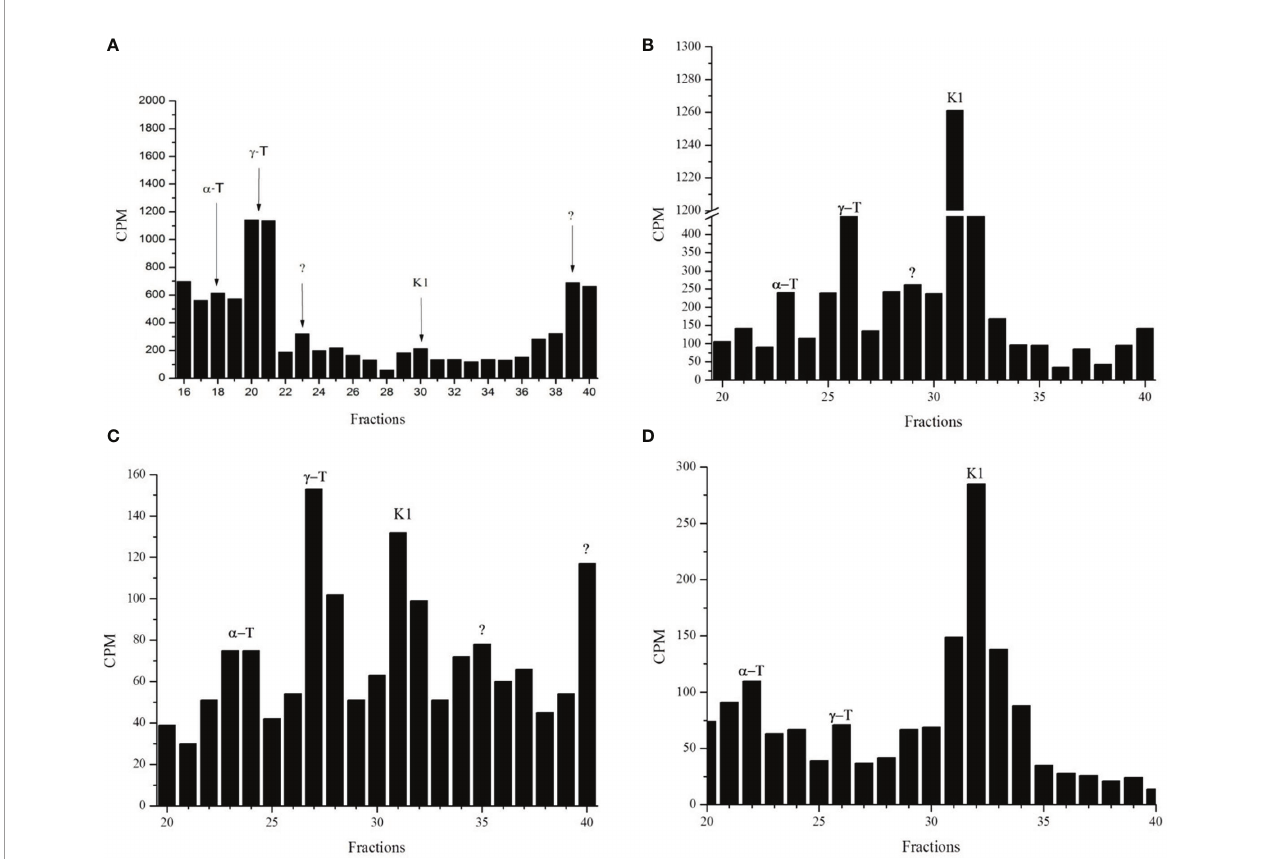
FIGURE 1 | Radioactive incorporation pro fi le for phytylated quinones in P. falciparum in schizont stage. Infected erythrocytes with schizont stages metabolically labeled with [ 3 H]-phytol (A) , [ 3 H]-GGPP (B) , [ 3 H]-FPP (C) or [ 3 H]-SAM (D) were subjected to hexane extraction. These extracts were separated by RP-HPLC (System I). Radioactive fractions were coincident with the corresponding standards g -T ( g -tocopherol), a -T ( a -tocopherol), K1 (phylloquinone), and “ ? ” (not identi fi ed). The experiment was performed three times by using isoprene precursors and twice by using [ 3